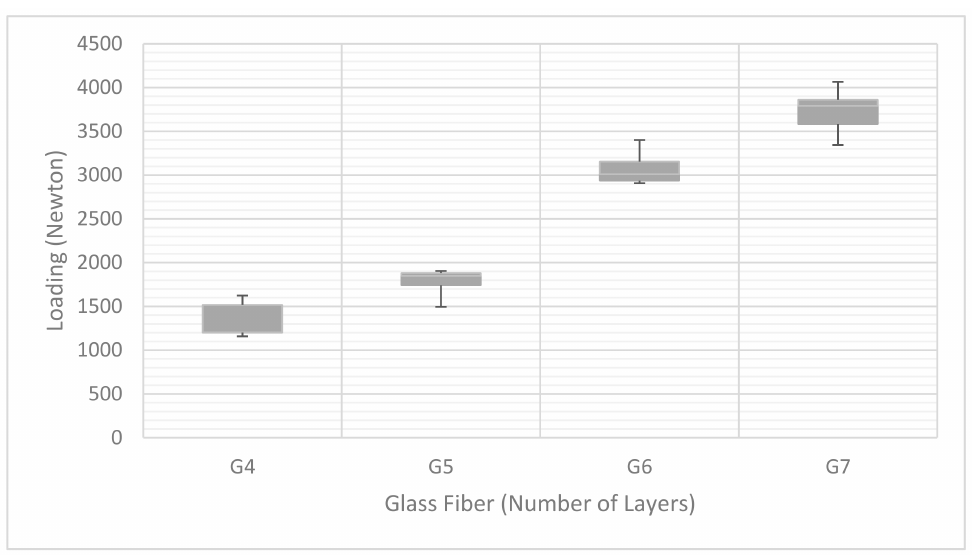
Figure 3. Load for Glass Fiber Composite Samples.